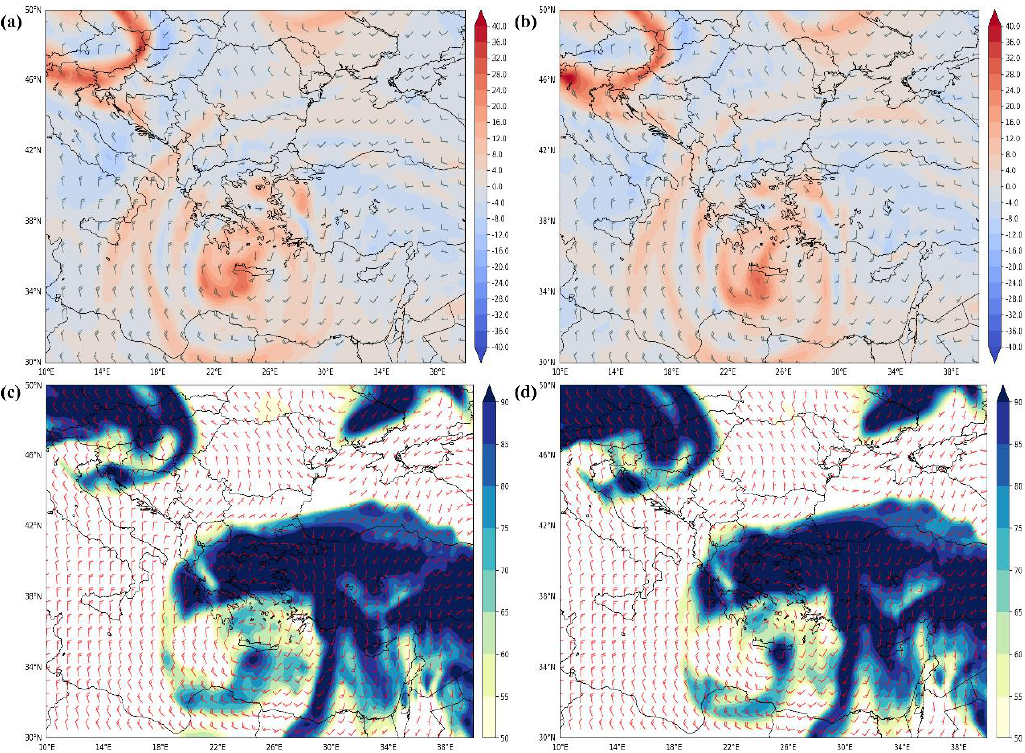
Figure A2. 500 hPa relative vorticity (shading; 10 −5 s −1 ) and wind barbs ( a , b ), and 700 hPa relative humidity (shading; %) and wind barbs ( c , d ) from the 0.25° × 0.25° ERA5 reanalysis data on 11 December 2009, 0000 UTC ( a , c ) and 0200 UTC ( b , d ).